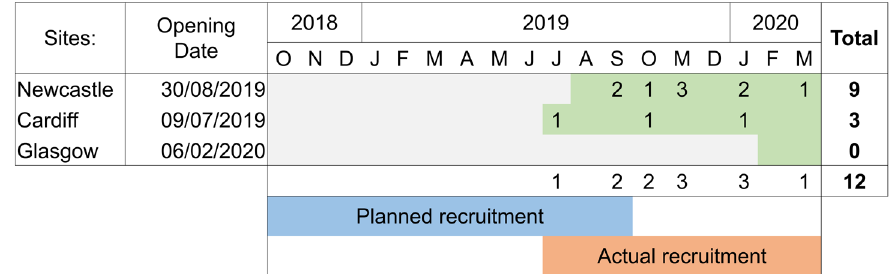
Figure 2. Recruitment timeline by month and site, whereby green shading indicates open for